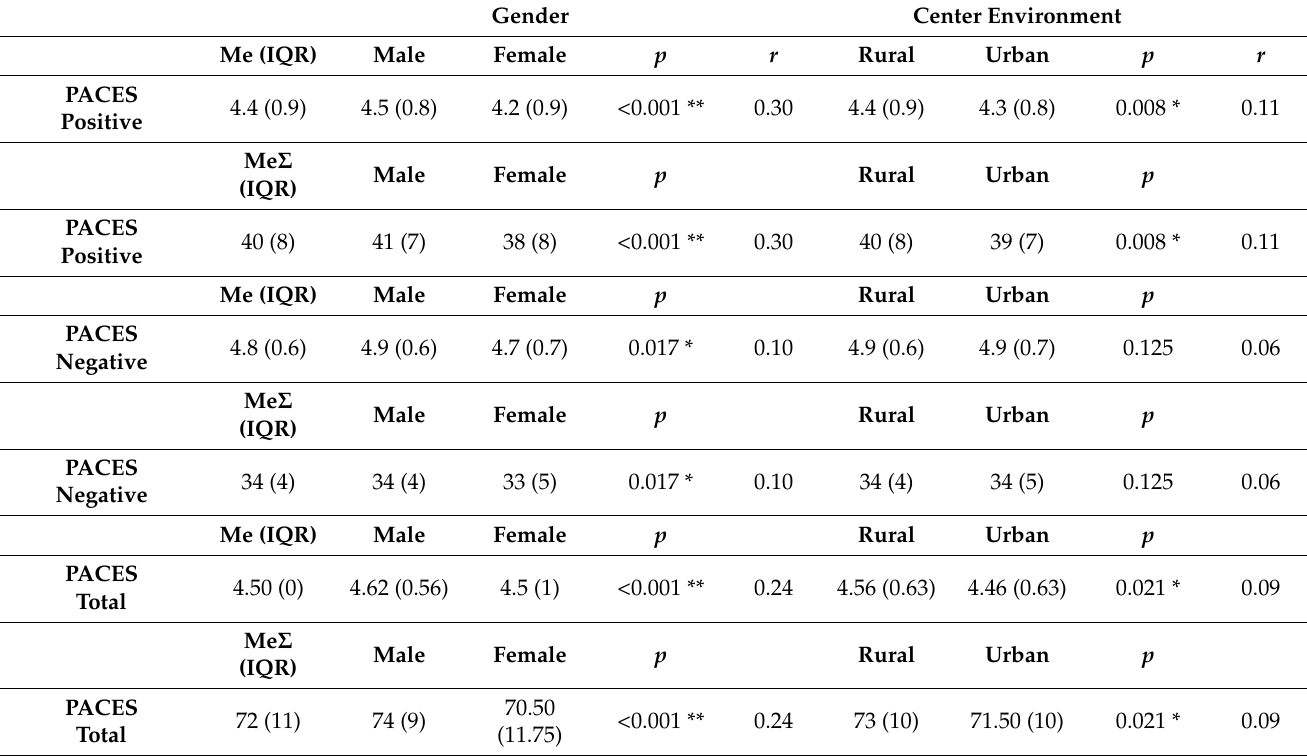
Table 3. Each dimension of the questionnaire was subjected to descriptive analysis.